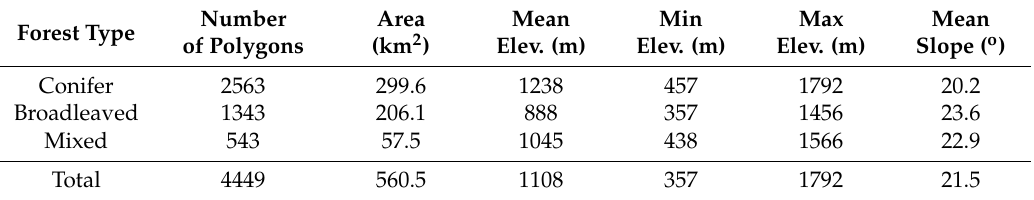
Table 2. Number and area of polygons used in this study for different forest types in non-OGF polygons. Forest Type